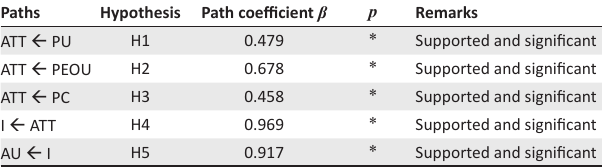
Structural model. TABLE 5: Summary of the hypotheses